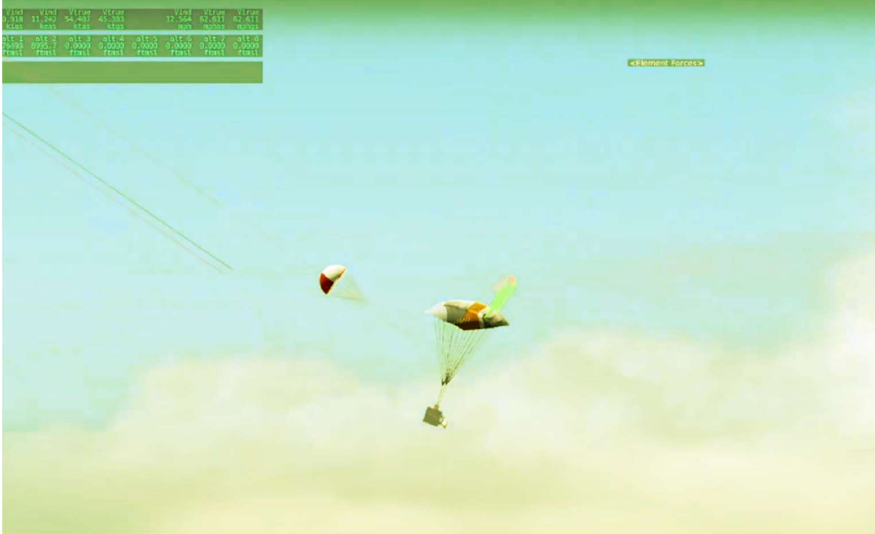
Figure 10. LOVE-Bug Para Wing Variant with tail drag